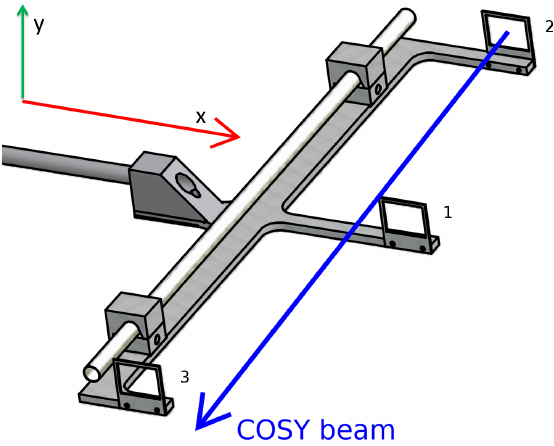
FIG. 9. Movable system with three frames of orifice cross ≈ 25 mm × 20 mm, at the upstream (2), section w × w x y center (1), and downstream position (3) of the storage cell, and one tube of 9.6 mm inner diameter and 400 mm length. The system is movable in the horizontal ( x ) and vertical ( y ) direction perpendicular to the beam while the beam passes through one of the apertures.